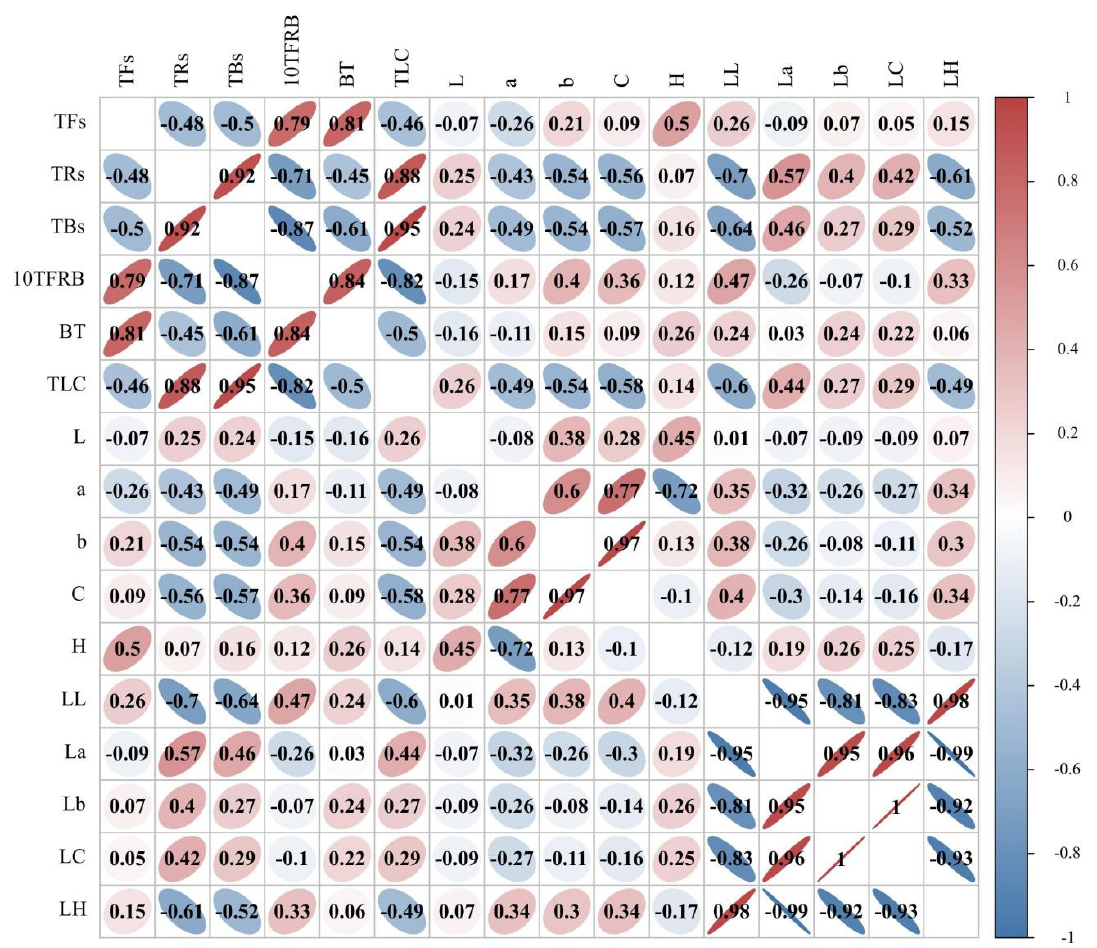
Figure 5. Correlation analysis between the color attributes and the tea pigment contents of fermented leaves.